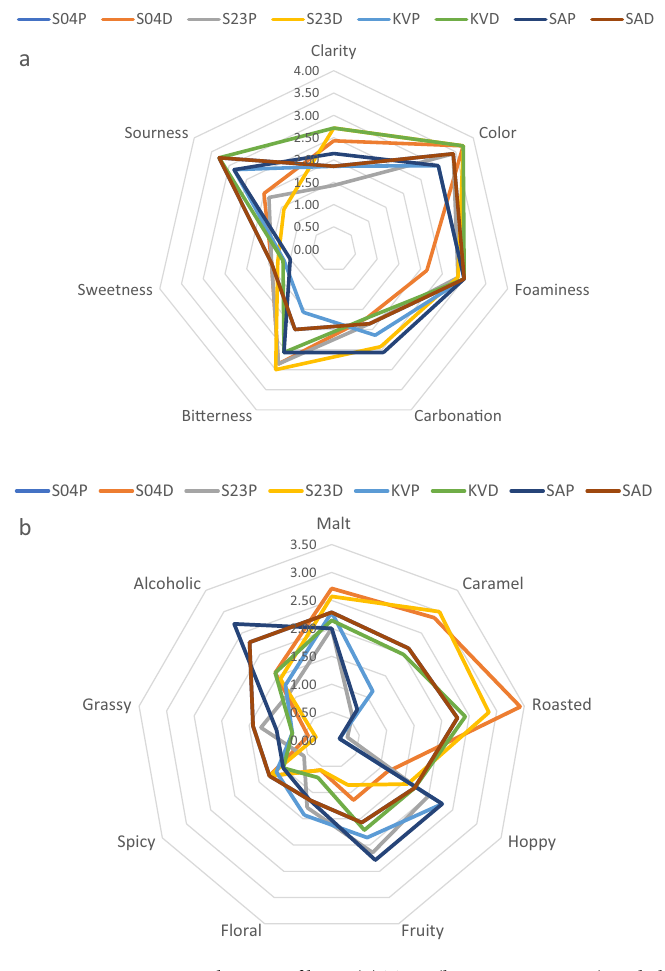
Figure 1. Sensory evaluation of beer, ( a ) Taste (bitter, sweet, sour) and clarity, color, frothiness, carbonation, ( b ) Aroma